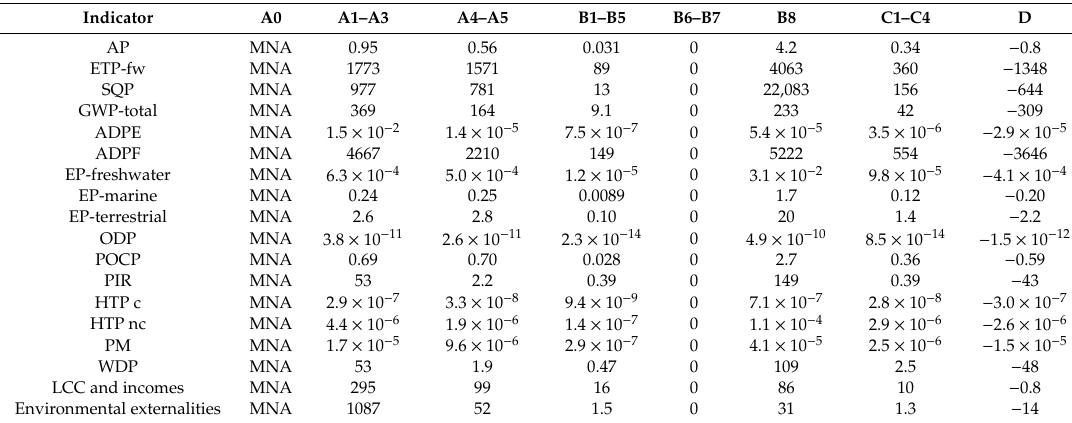
Table 7. Results for the SSC bridge design concept per indicator in units of measurement per life-cycle stage for the functional unit. Modules not assessed are abbreviated as